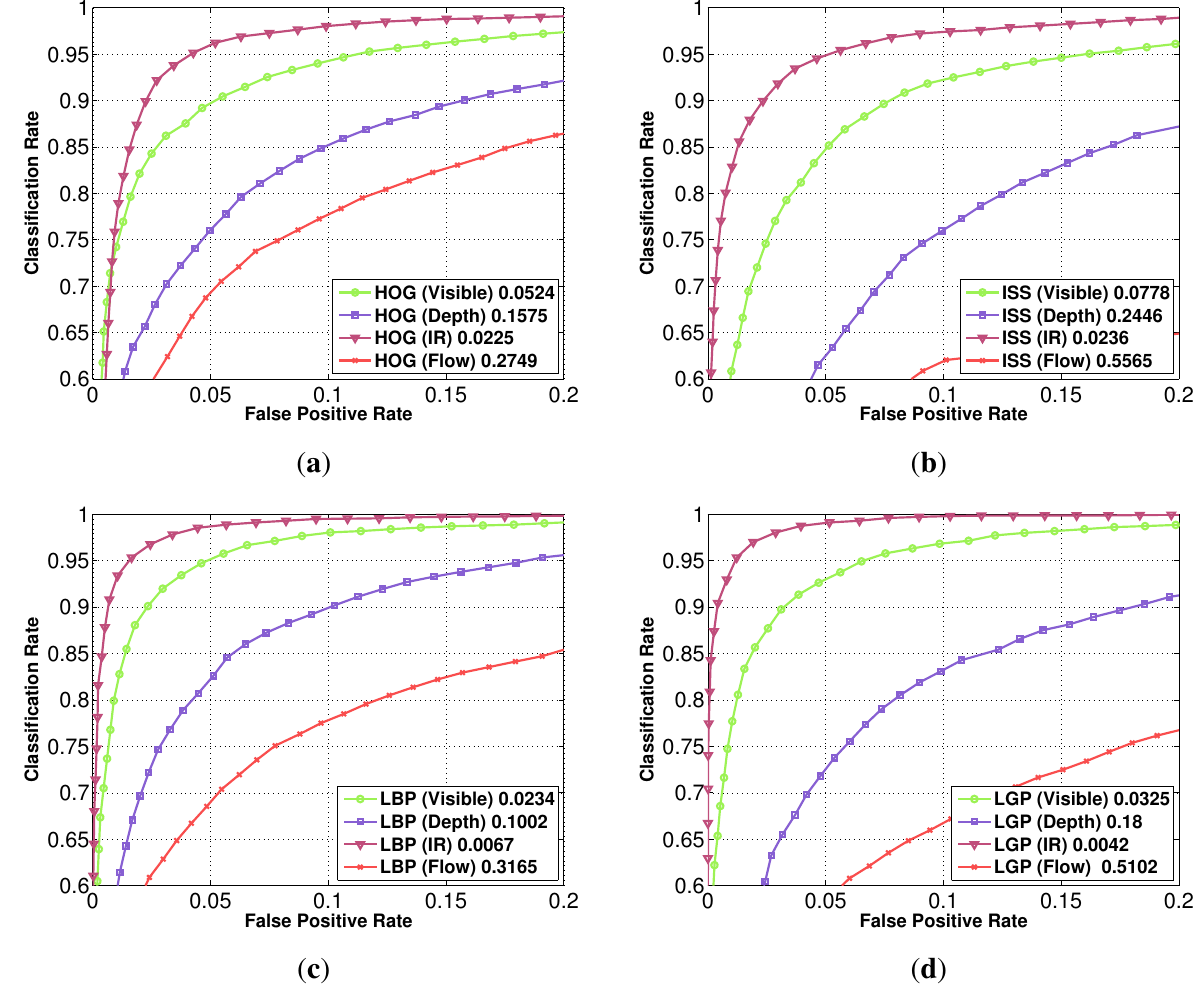
Figure 9. Individual classification (visible, depth, flow and IR) performance of: ( a ) HOG; ( b ) ISS; ( c ) LBP; ( d ) LGP. The reference point is the false positive rate obtained for a classification rate of